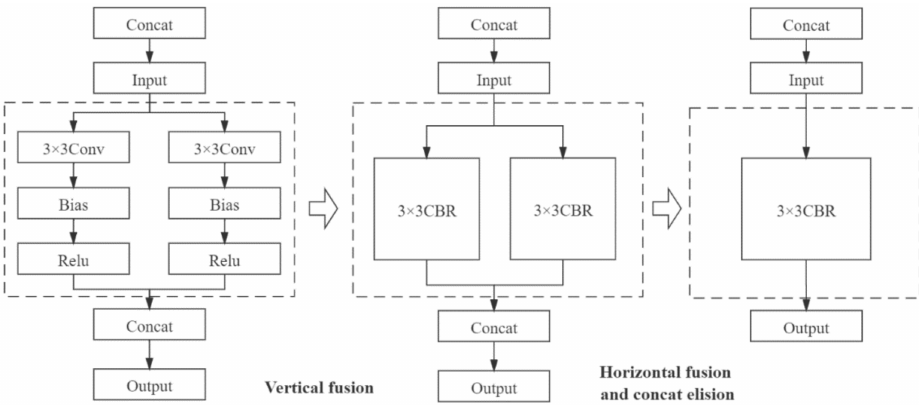
Figure 8. Optimization of convolutional neural network structure by